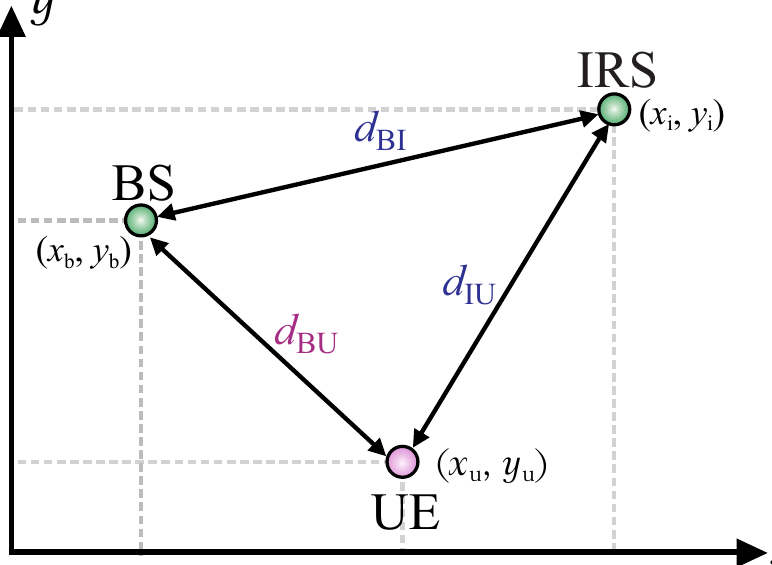
Figure 3. Simulation